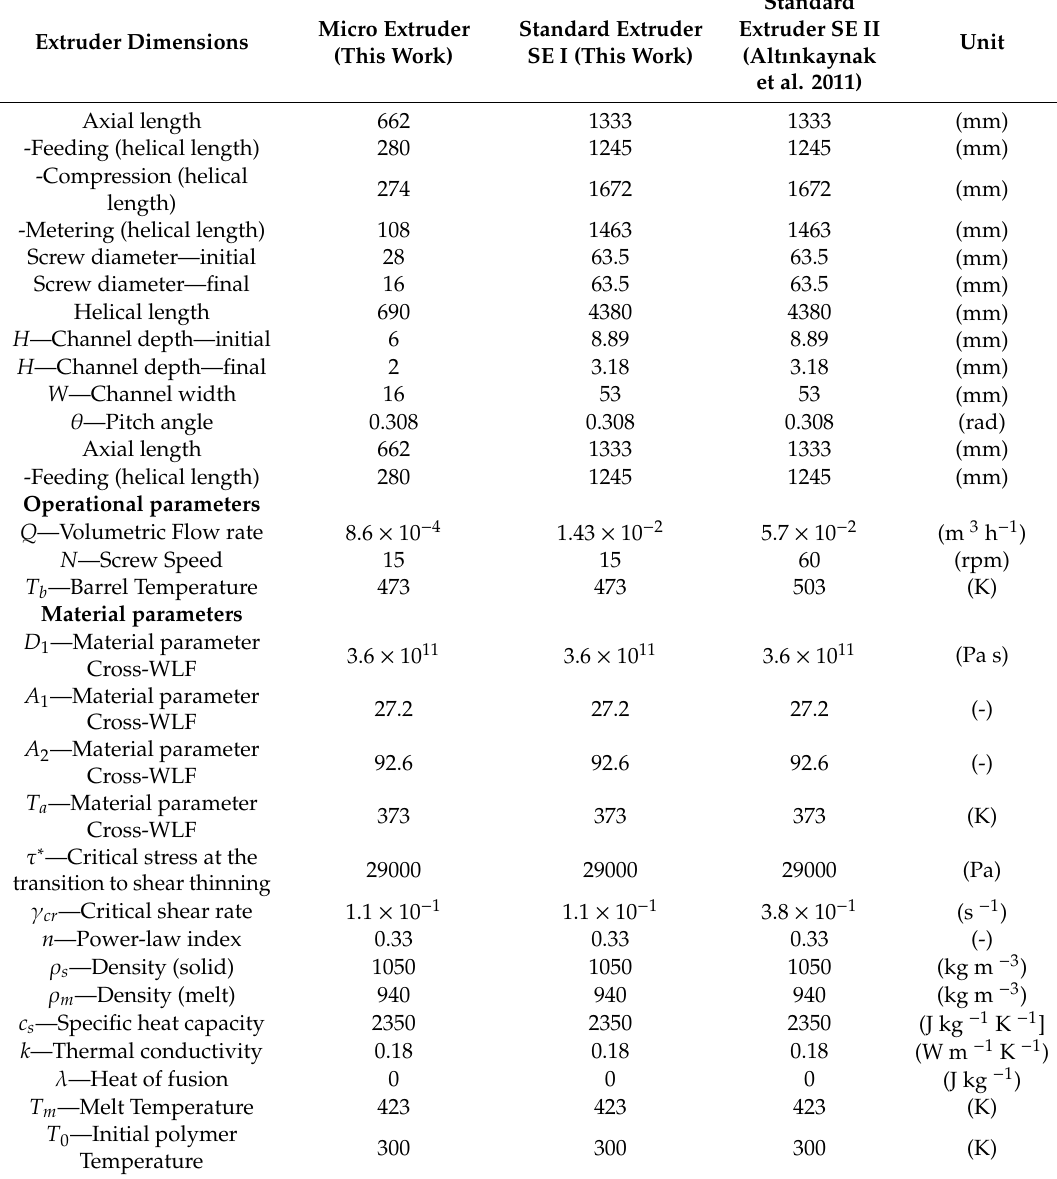
Table 1. Reference equipment dimensions and operational parameters as well as the ABS material parameters for one micro-extruder and two standard extruders with one having the same screw speed and barrel temperature as with